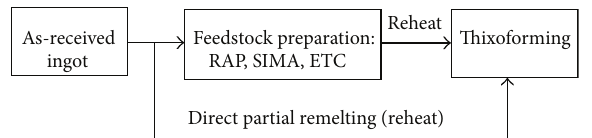
Figure 32: Schematic diagram of the different routes to obtain suitable thixformable microstructures.